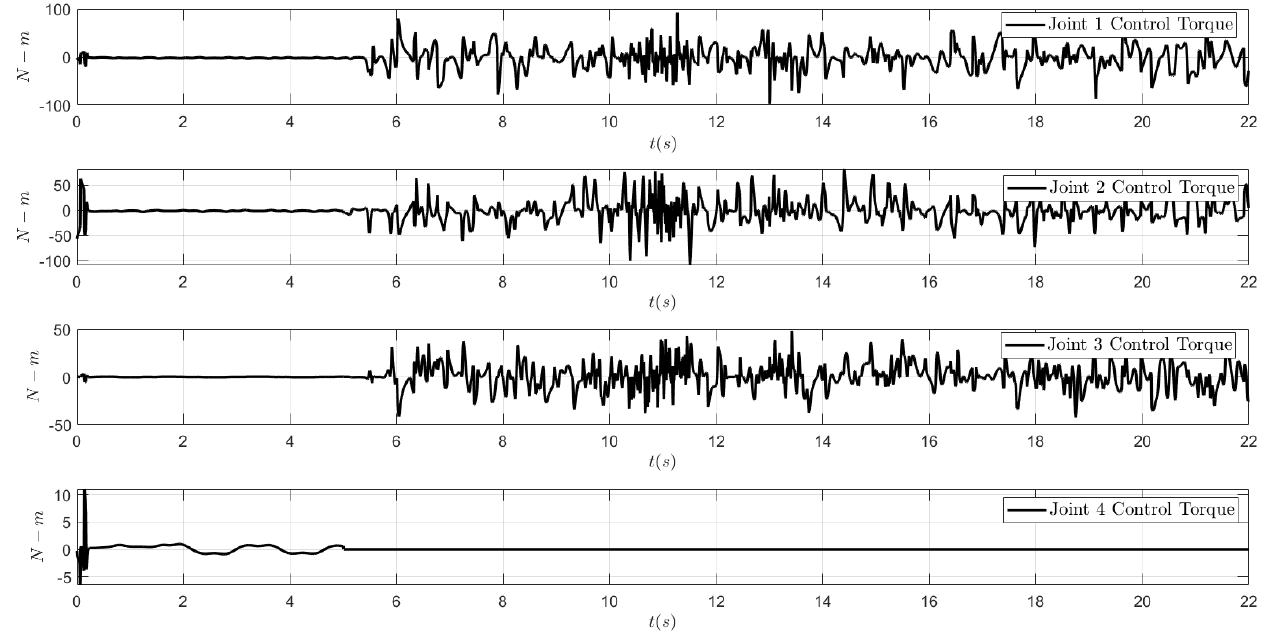
Figure 10. Control signal without adaptive chaos